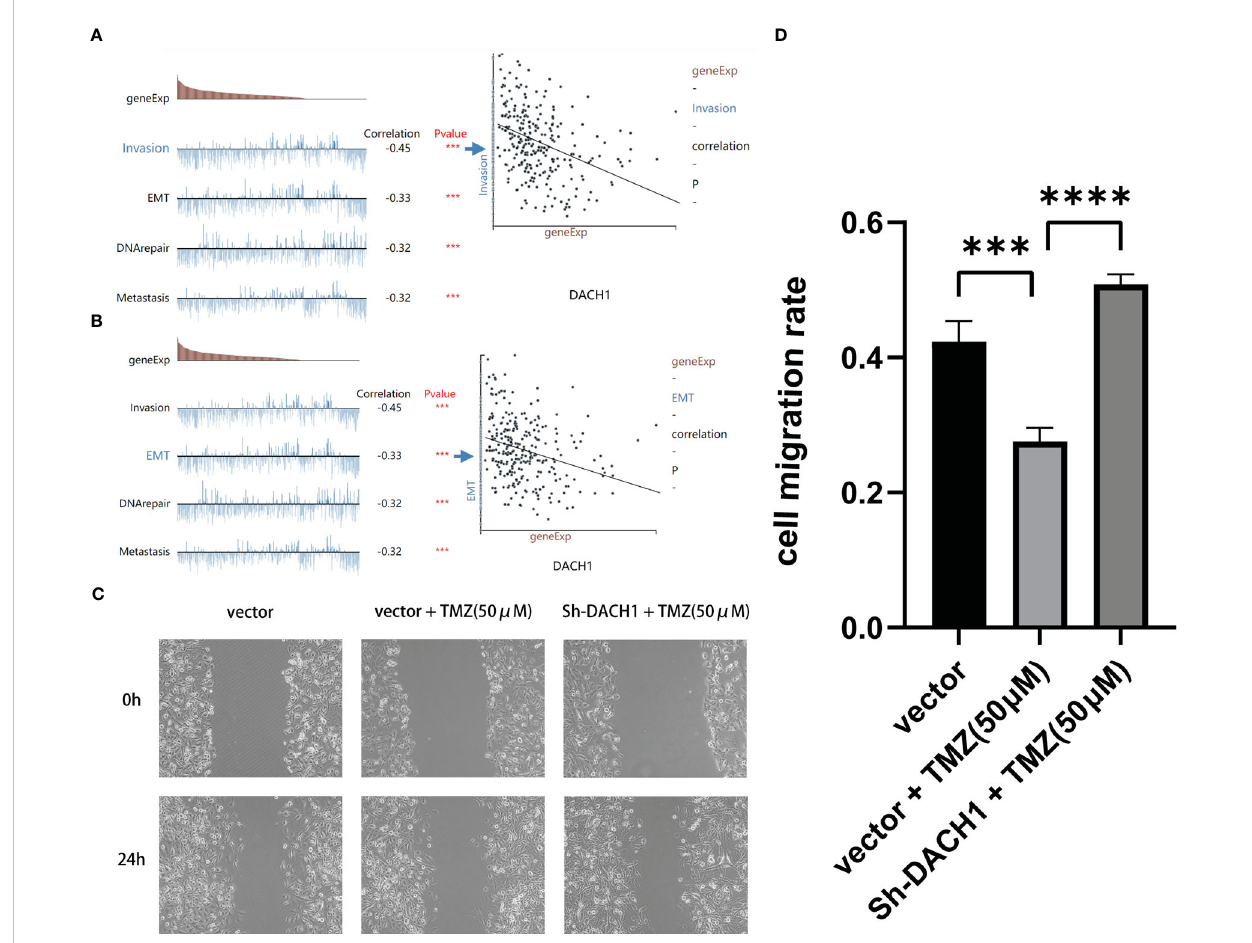
FIGURE 9 (A, B) The cancerSEA website predicts that the lower the expression of DACH1, the stronger the function of invasion and EMT in GBM. (C, D) The results of scratch experiments show that the cell migration rate was signi fi cantly lower in the vector+TMZ (50 m M) group than in the vector group (P < 0.05) and signi fi cantly higher in the Sh-DACH1+TMZ (50 m M) group than in the vector+TMZ (50 m M) group (P <